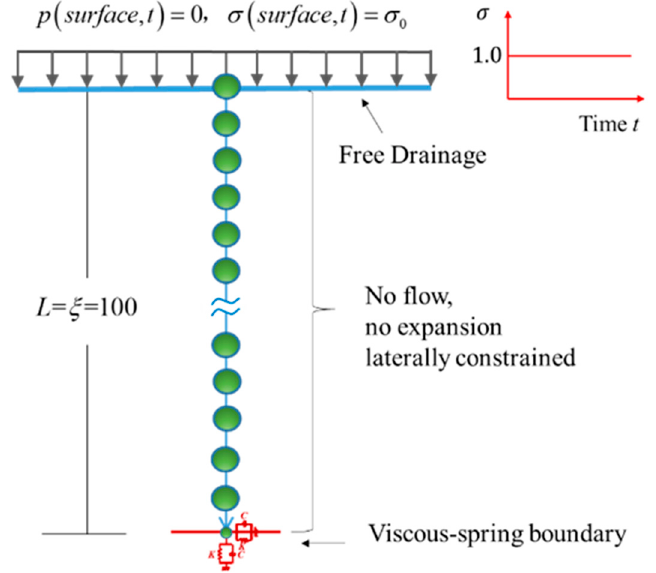
Figure 3. Numerical model for 1D saturated porous media. Table 1. Parameters of linear elastic saturated soil.